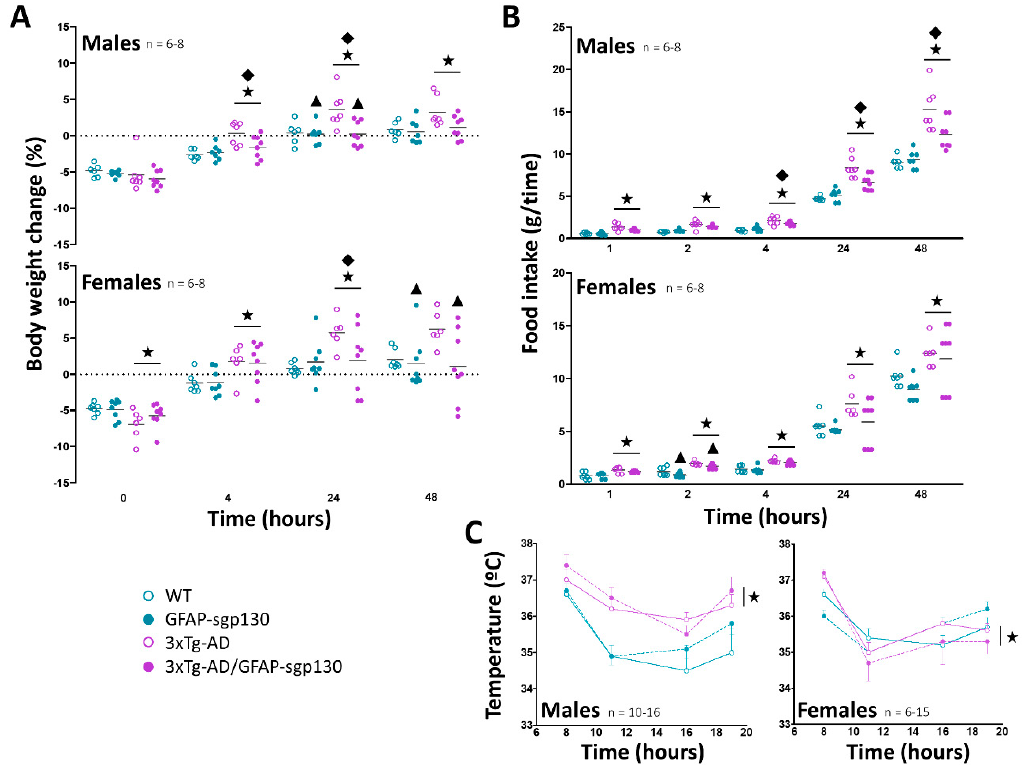
Figure 3. Fasting and refeeding analysis and basal temperature in mice fed with control diet. ( A ) After fasting, 3xTg-AD mice lost more weight than controls (significant in females), without effects of the IL-6 trans-signaling inhibition. Once the animals were re-fed, 3xTg-AD animals gained weight quicker than controls, a response blunted by the blocking of IL-6 trans-signaling. ( B ) A post-fasting hyperphagia was observed in the 3xTg-AD mice, a response again blunted in some cases by the blocking of IL-6 trans-signaling. ( C ) Higher body temperatures were observed in the earlier hours of the day, when 3xTg-AD mice showed an increase compared with controls. This effect was maintained throughout the day in males. No effect of the inhibition of the IL-6 trans-signaling was observed. Results are MEAN ± SEM. ★ p ≤ 0.05 vs. 3xTg-AD negative; ▲ p ≤ 0.05 vs. sgp130Fc negative; ◆ Indicates a significant interaction between both factors. 3.3. 3xTg-AD Mice Showed Lower Hormonal and Cholesterol Levels in Serum, although There Were No Differences in Glycaemia Figure 4A shows the hormones and blood metabolites after the HFD in all genotypes and both sexes. 3xTg-AD females presented lower (~32.3% in 3xTg-AD vs WT) cholesterol (p=0.006 R 2 =0.28),